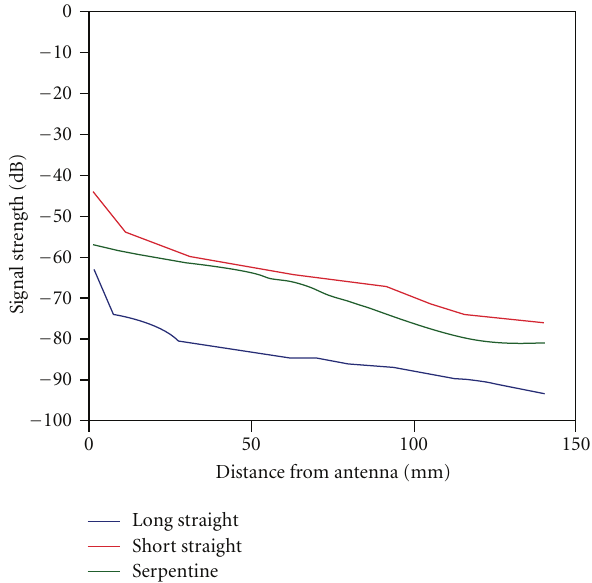
Figure 11: Graph of the 900 MHz electric field magnitudes (dB) along the lower side of the Plexiglas :liquid interface from the point directly under the antenna and extending horizontally for all three distributions shown in Figure